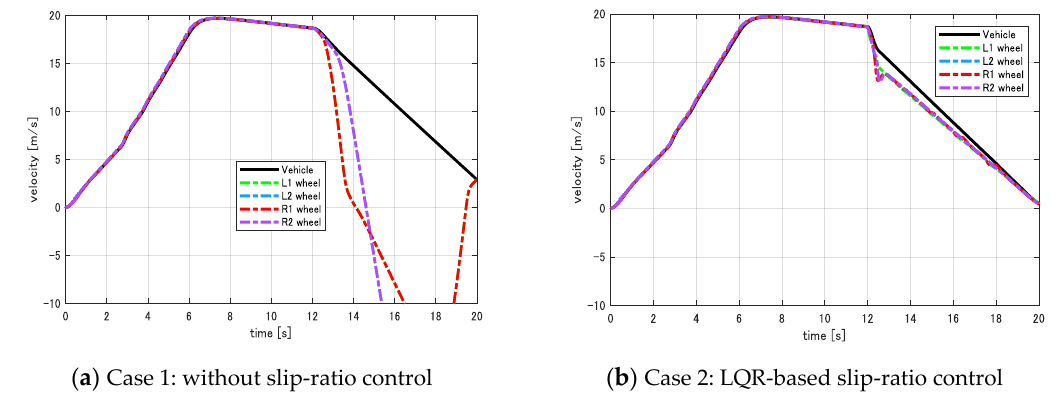
Figure 21. Simulation results of slip-ratio control in deceleration mode.